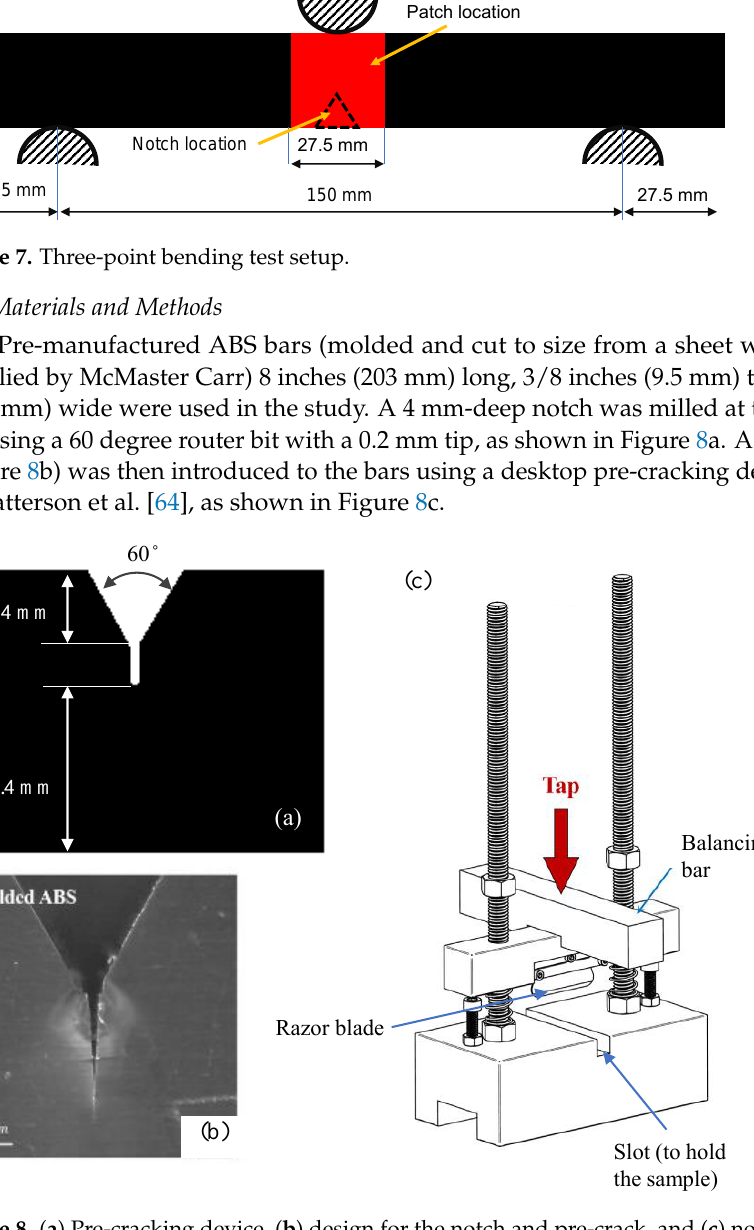
Figure 8. ( a ) Pre-cracking device, ( b ) design for the notch and pre-crack, and ( c ) notch and